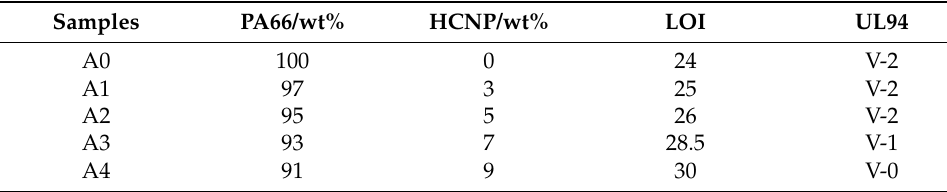
Table 1. The LOI and UL-94 results of FR-PA66.